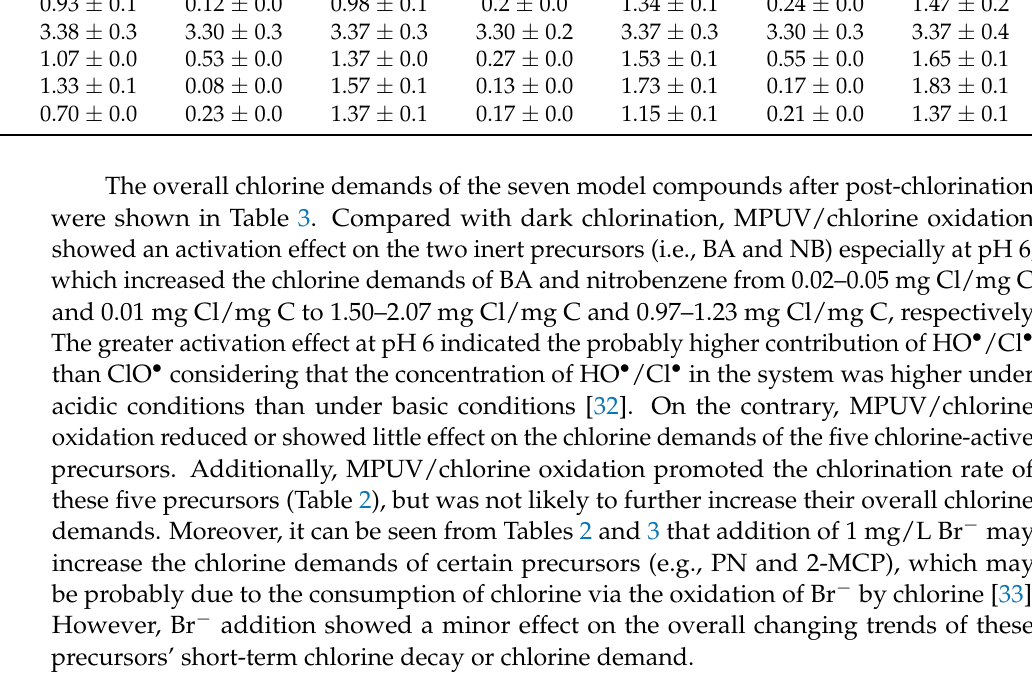
Chlorine demands of the seven model compounds after the 60 s short-term ox- idation under the following conditions: Chlorine dose = 10 mg Cl 2 /L, pH = 6.0 or